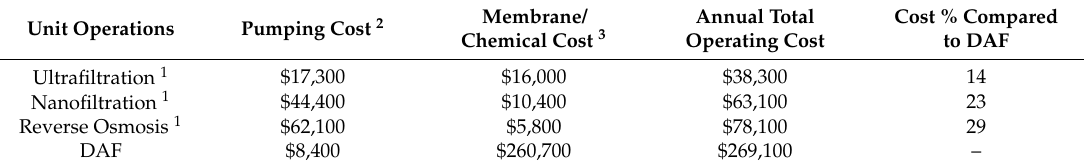
Table 5. Annual cost estimations of membrane operations based on our lab scale rendering facility wastewater treatment data. In this calculation, manufacturer suggested membrane lifetimes are